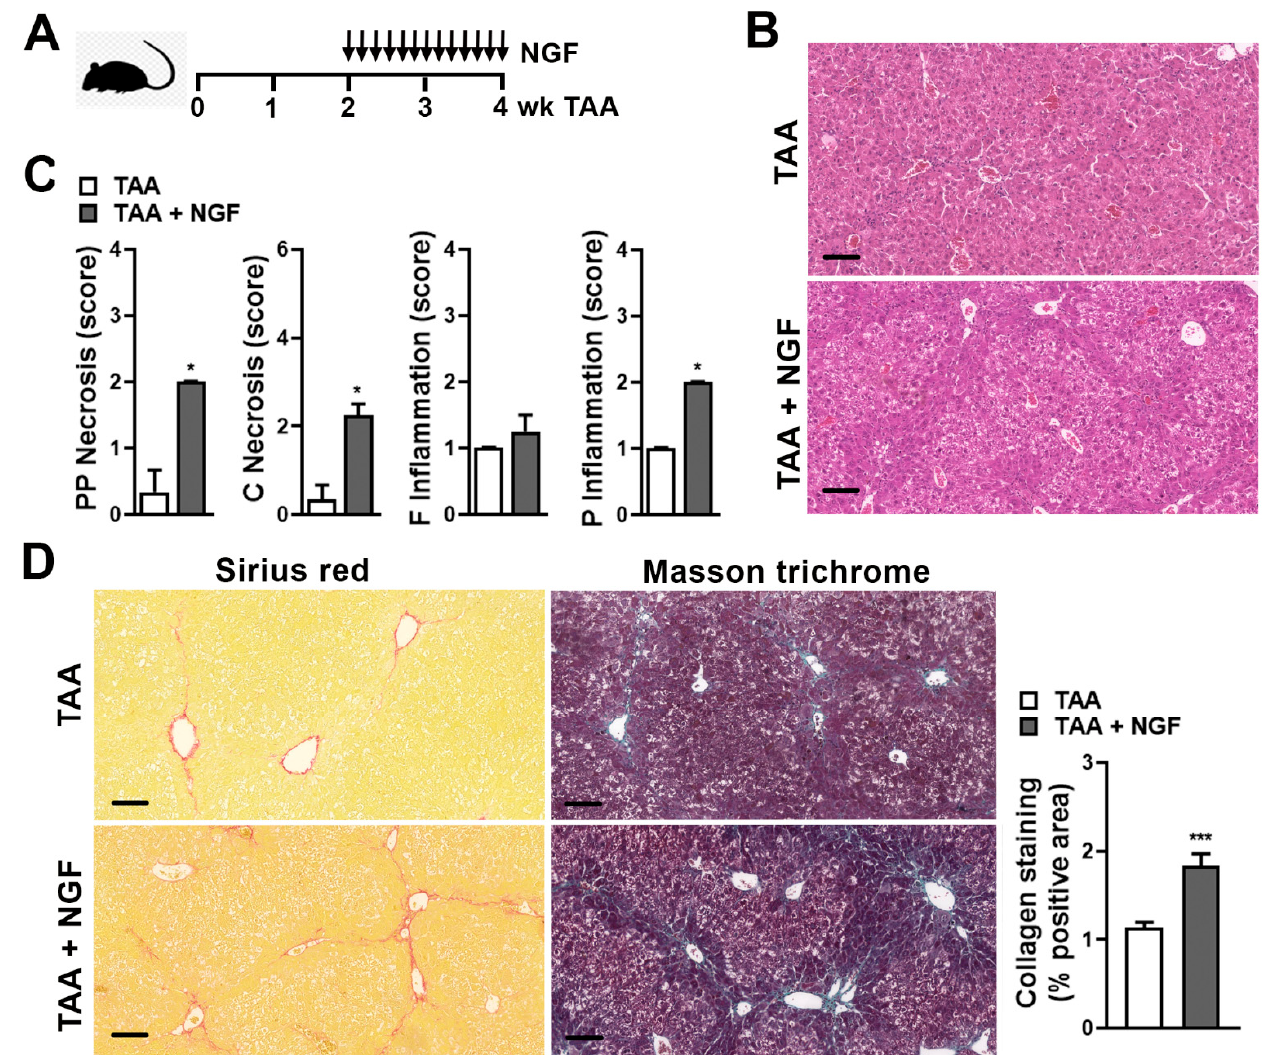
Figure 3. ( A ) Experimental murine model: Thioacetamide (TAA) was administered for 4 weeks (wk) to induce fibrosis and NGF administration was performed daily starting on week 2 of TAA administration. ( B ) Representative images of H&E staining on liver sections of mice with fibrosis (TAA) and fibrosis and NGF administration (TAA + NGF). Bar = 100 µ m. ( C ) Score of periportal and periseptal (PP) necrosis, confluent (C) necrosis, focal (F) inflammation, and portal (P) inflam- mation. Results are expressed as mean score ± S.E.M. * p < 0.05 (Kruskal–Wallis test). ( D ) Representative images of Sirius red and Masson’s trichrome staining on liver sections. Bar = 100 µ m. Quantification of collagen deposits based on Sirius red-stained sections was performed by morphometric analysis and % positive area ± S.E.M is shown. *** p < 0.001 (Kruskal–Wallis test).